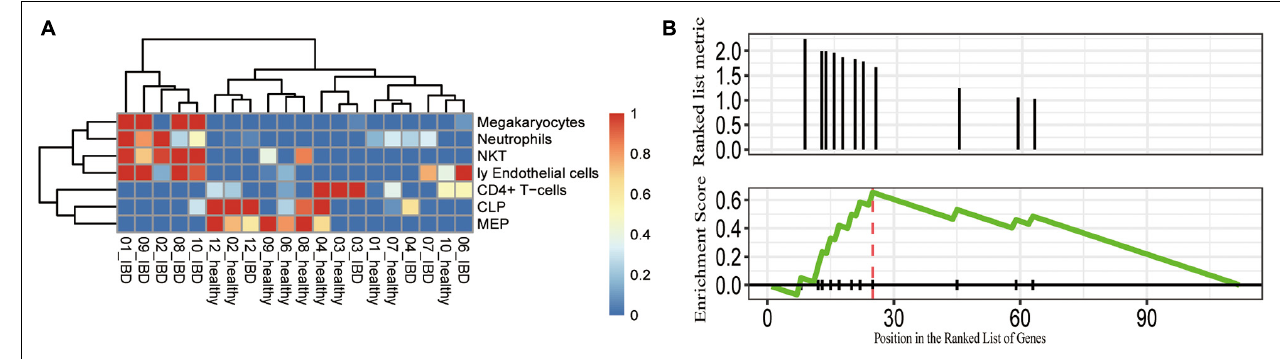
FIGURE 4 | Potentially dysregulated immune cell subpopulations and pathways identified in the discordant IBD twin pairs. (A) The cell subpopulations that differ between the healthy and control. The scaled cell proportions were shown in the heatmap. (B) GSEA showing that the DEGs enriched in the gene set were upregulated in cortical and medullary thymocytes. CLP, common lymphoid progenitor; MEP, megakaryocytic-erythroid progenitors; Ly endothelial cells, lymphatic endothelial cells; NKT, natural killer T